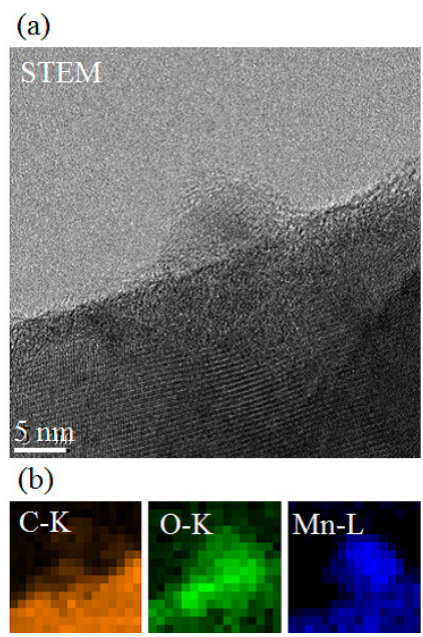
Figure 4. ( a ) Bright field-scanning TEM (BF-STEM) image of glucose-treated Mn-PBA; ( b ) Electron energy loss spectroscopy (EELS) images at C-K, O-K, and Mn